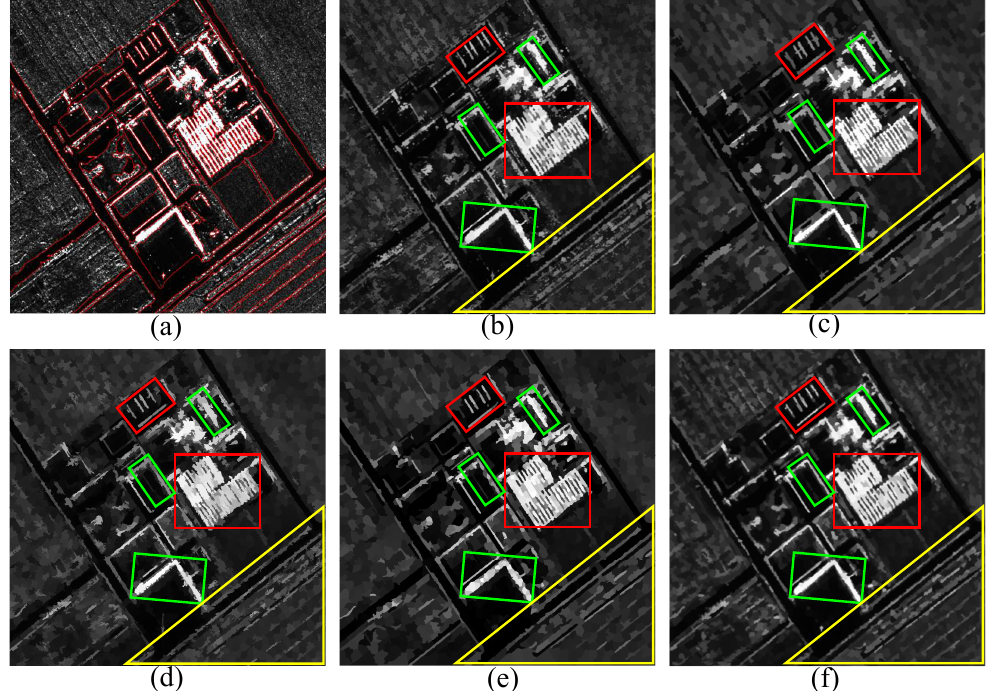
Figure 11. Superpixel generation results of the five methods for the X-band SAR image. ( a ) Ground truth. ( b ) SRMP. ( c ) MIPS. ( d ) LSC. ( e ) ESOM. ( f )